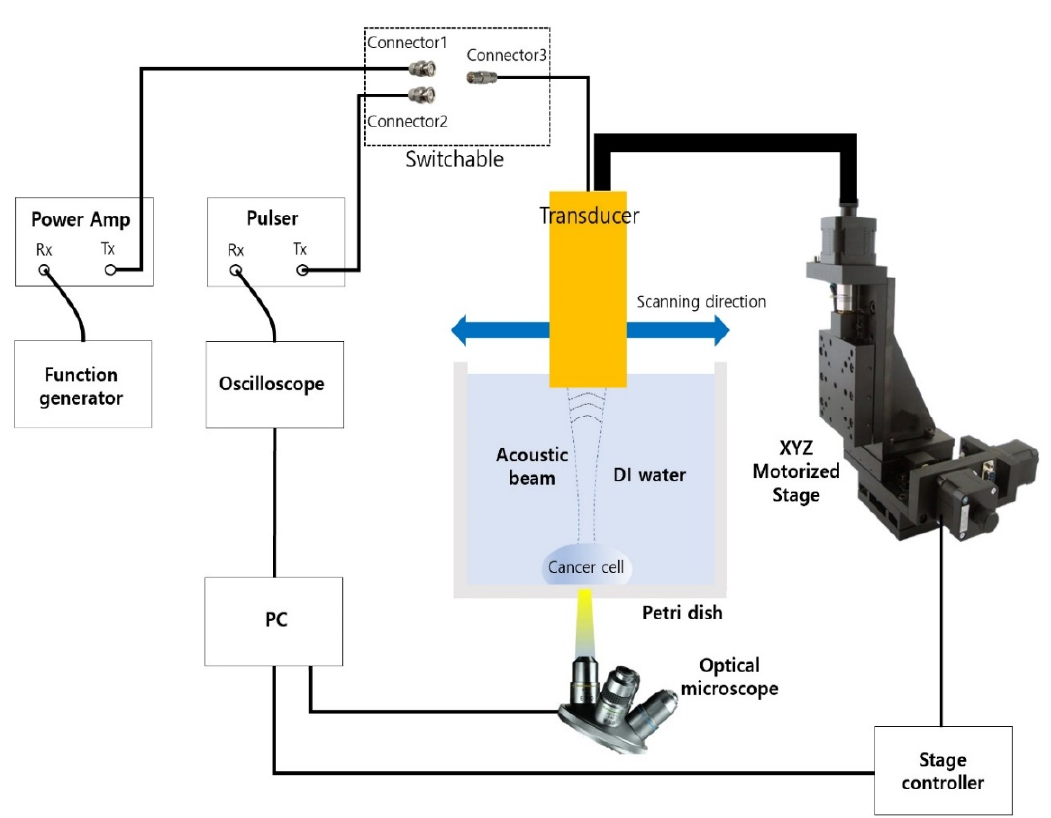
Figure 4. Experiment setup for B-mode cell imaging and acoustic tweezer.